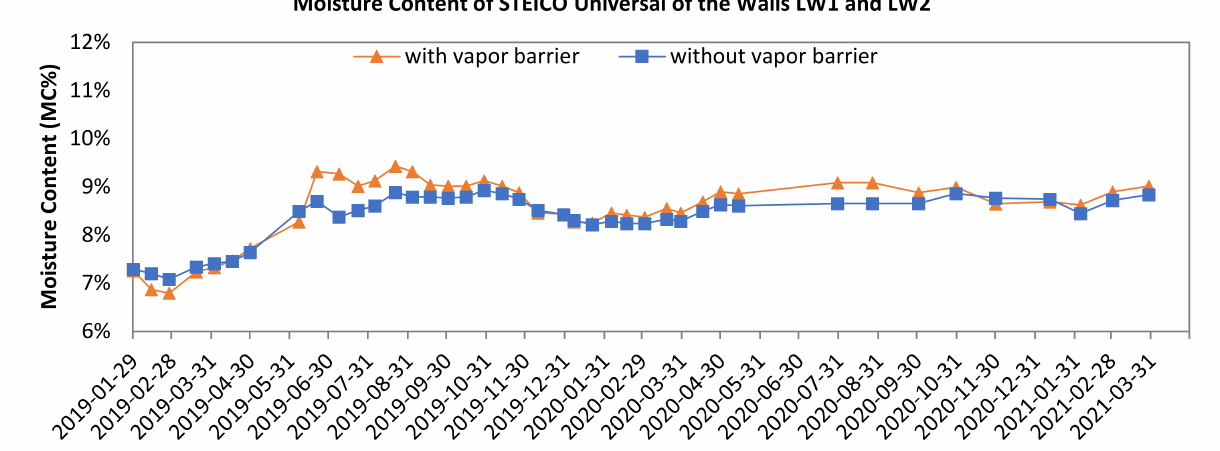
Figure 10. The Moisture Content of Fiberboard Insulation following Vapor Barrier.In the wall LW1 with the vapor barrier the insulation STEICO Universal reached slightly higher moisture content during the spring and the summer, it was especially due to reversed vapor transfer, i.e., outdoor humidity moves indoors entering the wall. The vapor barrier prevents the vapor transfer, and it was accumulated in the insulation situated in front of the barrier.